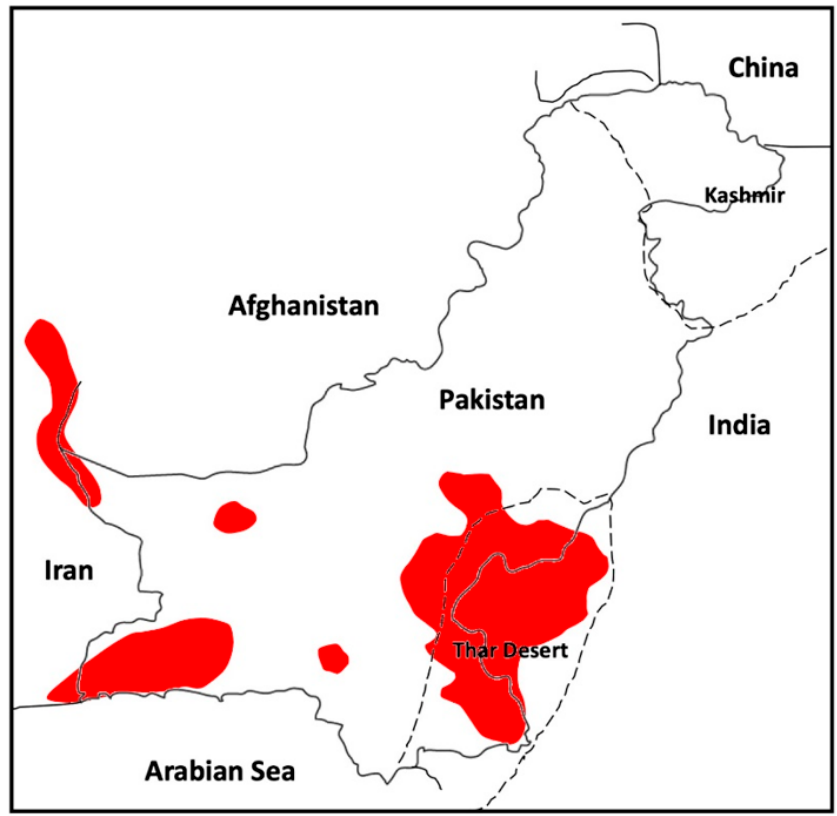
Figure 9. Locations and regions mentioned in the text in relation to desert locust activity and insecurity on the India-Pakistan border. Primary breeding areas in red. Mali. Direct Insecurity. The Adrar des Iforas region of northern Mali (Figure 10) is an important desert locust breeding area [29], inhabited by the Tuareg people [57]. In the early 1990s, the Tuareg turned from occasional banditry [58] to rebellion [59]. Five Malian troops protecting a desert locust surveillance team were killed by Tuareg rebels in 1994 [8] and the insurrection restricted travel around breeding areas [7,8]. Desert locust operations in northern Mali were impeded relatively often through 2016 [4,18]. If gregarious desert locusts were to become active in Mali in the near future, surveillance and control operations might experience direct insecurity-related